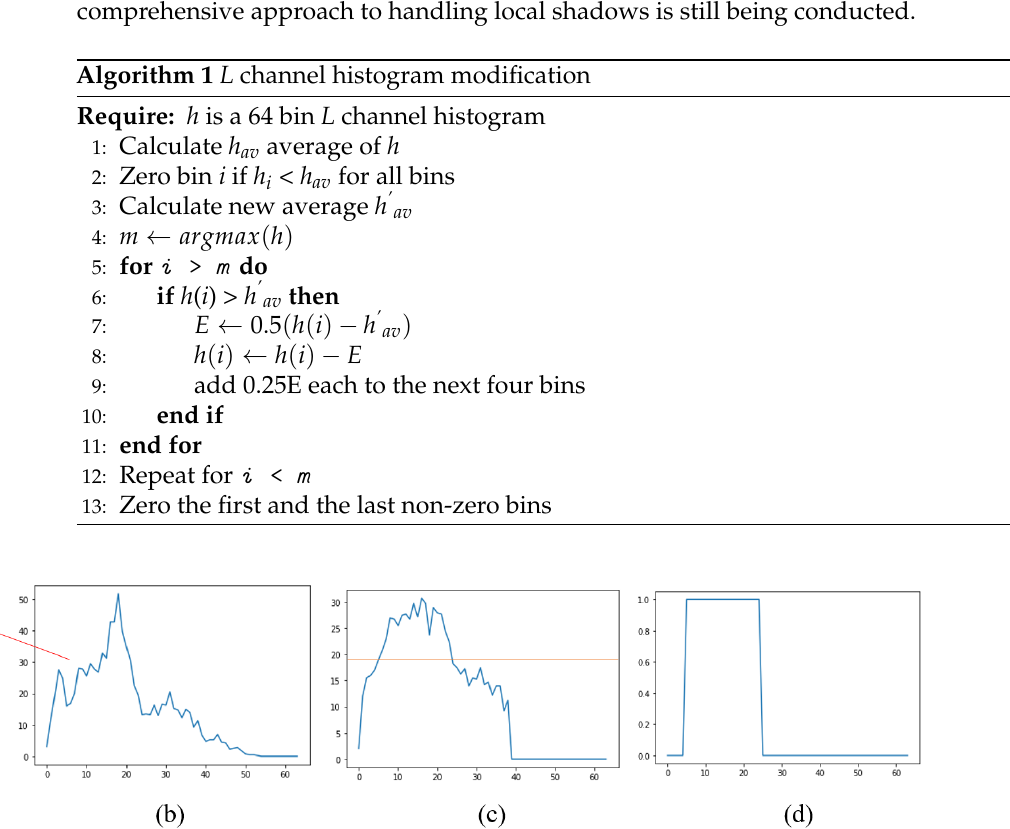
Figure 2. Histogram modification and binarization: ( a ) query image; ( b ) L channel histogram of one of the classes (e.g., upper clothes); ( c ) modified histogram; and ( d ) binarized histogram after